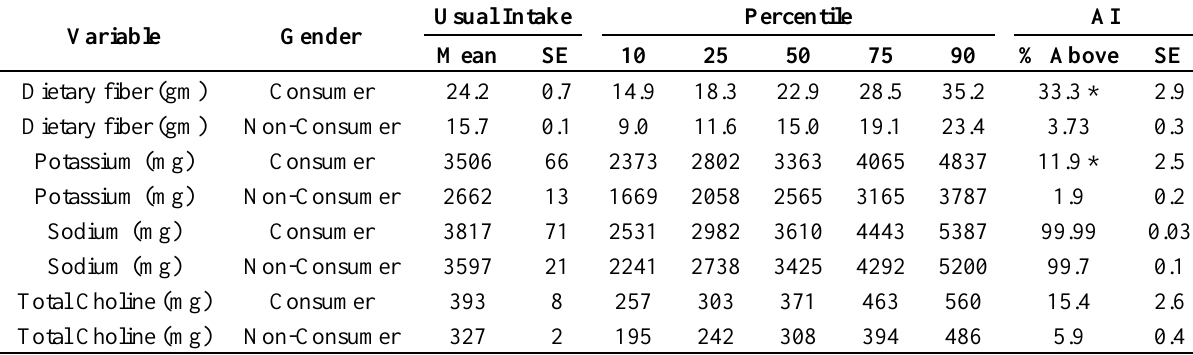
Table 3. Usual intake and percentage of the population above the adequate intake in tree nut consumers compared with non-tree nut consumers.